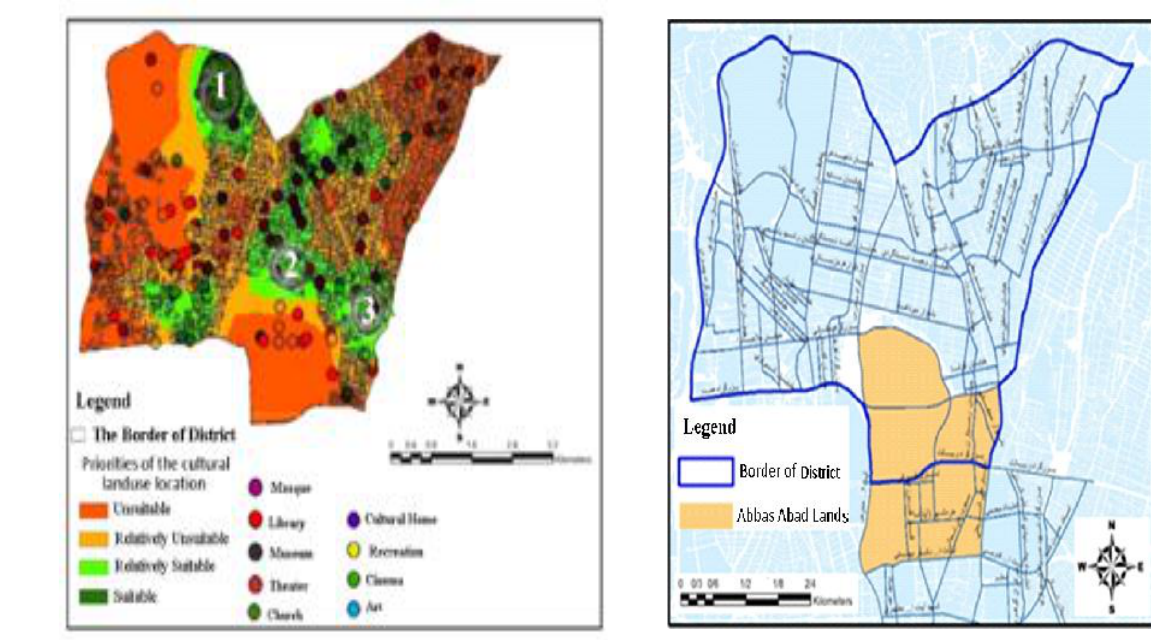
Fig. 20: The Local Value of the existing cultural land use Fig. 21: The geographical position of the Abbas Abad